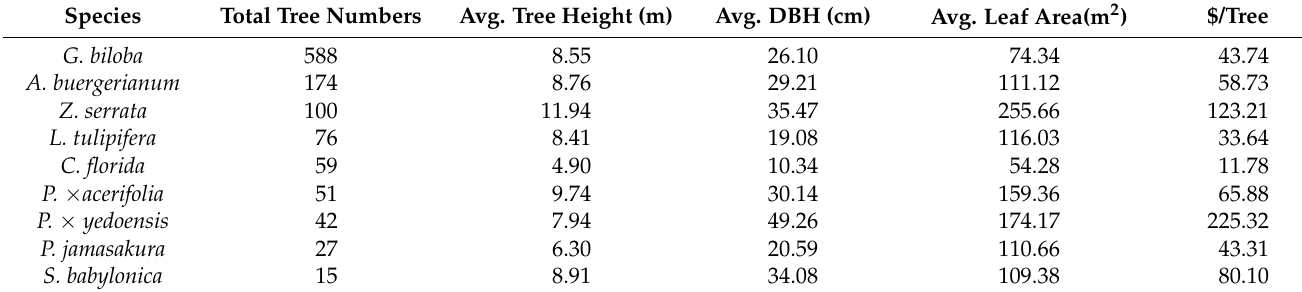
Table 10. Monetary value of predominant street tree species in Kyoto